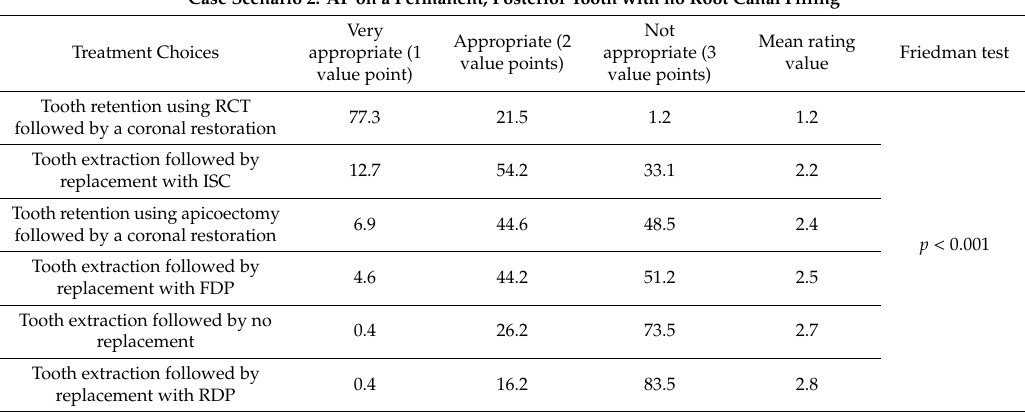
Table 4. Pre-preferences of survey participants regarding case scenario 2 in %, mean rating value and results of the Friedman test comparing all treatment